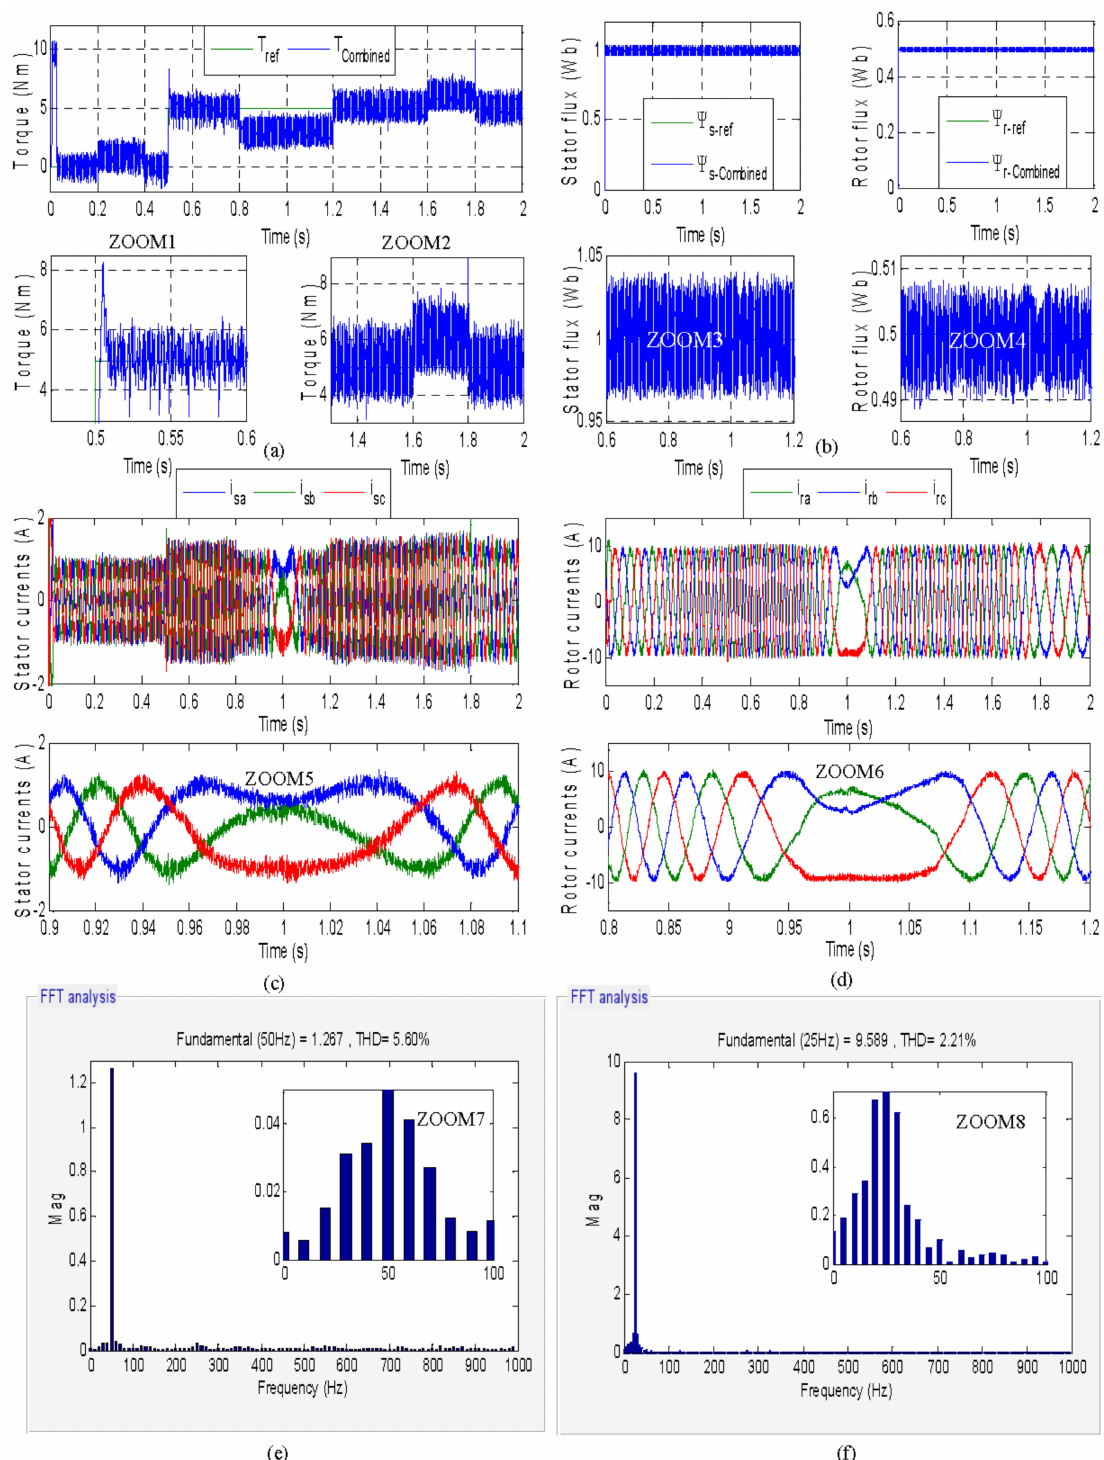
Figure 10. GA-DTC-weighted performances. ( a ) The electromagnetic torque response. ( b ) The fluxes response. ( c , d ) The stator and rotor currents. ( e , f ) Harmonic spectra of the stator and rotor